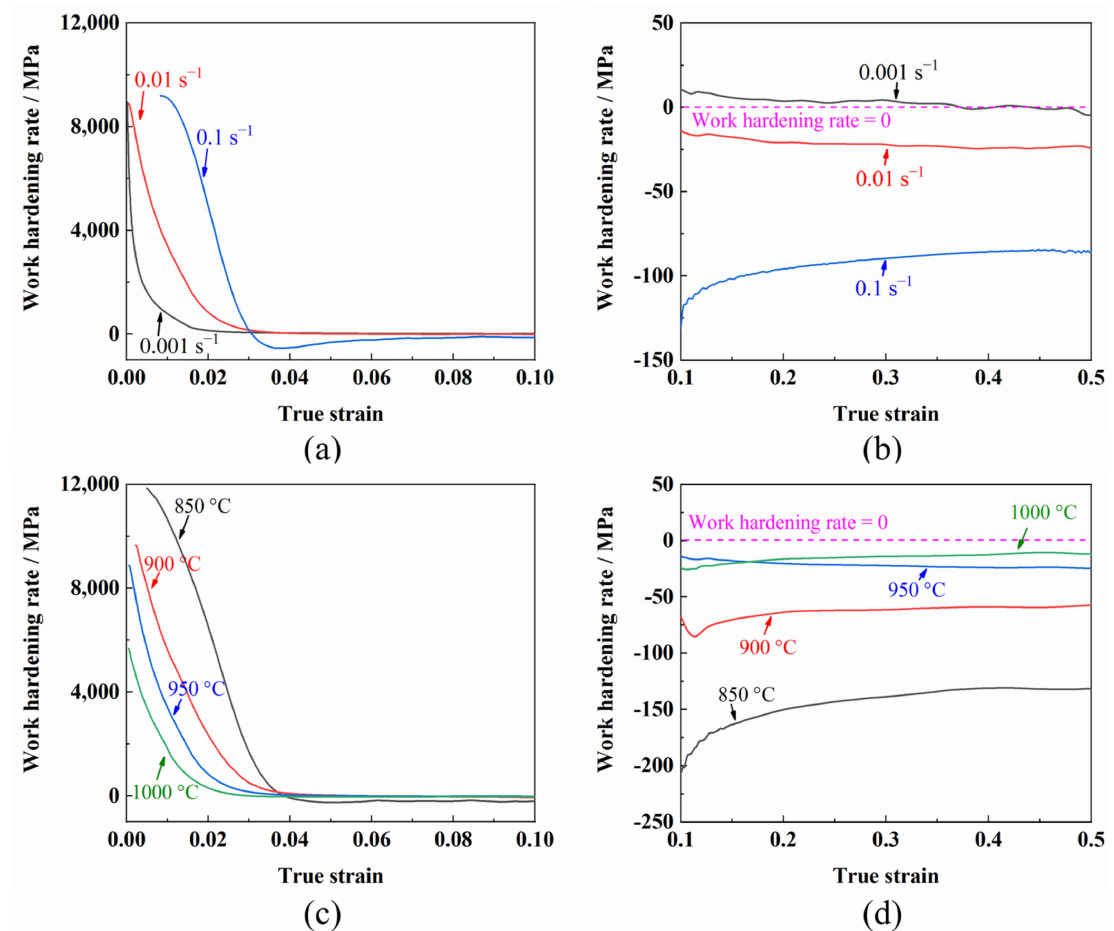
Figure 5. Work hardening rate at different deformation conditions: ( a , b ) 950 ◦ C; ( c , d ) 0.01 s − 1 ; (( a , c ) are lower strain conditions; ( b , d ) are relatively higher strain conditions).